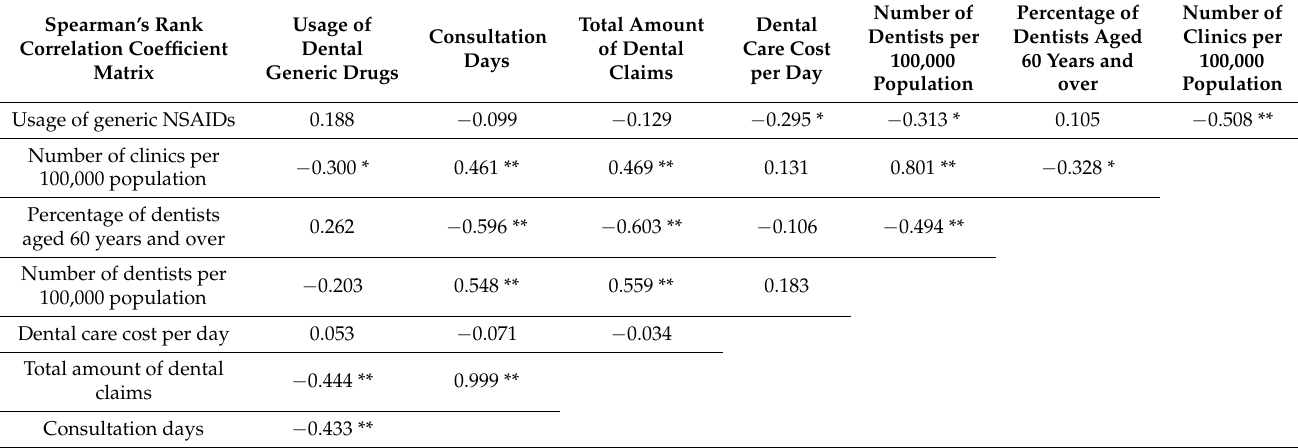
Table 2. Correlation analysis between usage of each generic drug and indicators (Spearman’s rank correlation coefficients). Spearman’s Rank Correlation